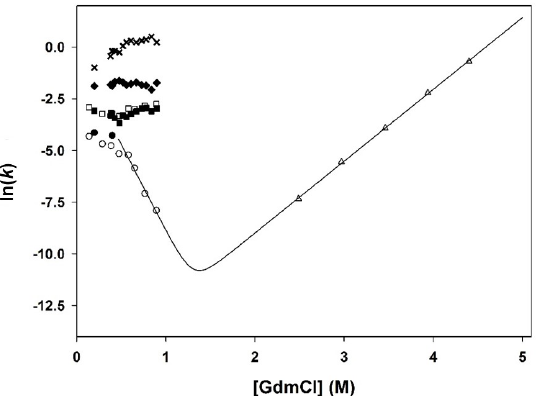
Figure 6. GdmCl concentration dependence of the rate constants for PemA folding at pH 7, 25 °C. Circles and squares represent the logarithm of the observed rate constants (in s − 1 ) for slow refolding (phases 3 and 4 in Table 1); diamonds and crosses are for fast refolding (phases 1 and 2), whereas triangles correspond to the unfolding rate constant. Data obtained after rapid mixing are represented by closed symbols, while those obtained following manual mixing are shown by open symbols. The solid line represents the fit of Equation (3) to the data obtained with GdmCl concentration in the range from 2.5 to 4.5 M (triangles), using k fH2O = 0.8 ± 0.2 s − 1 , m kf = 21 ± 2 kJ·mol − 1 ·M − 1 , k uH2O = (1.2 ± 0.1) · 10 − 7 s − 1 , and m ku = 9 ± 1 kJ·mol − 1 ·M − 1 .